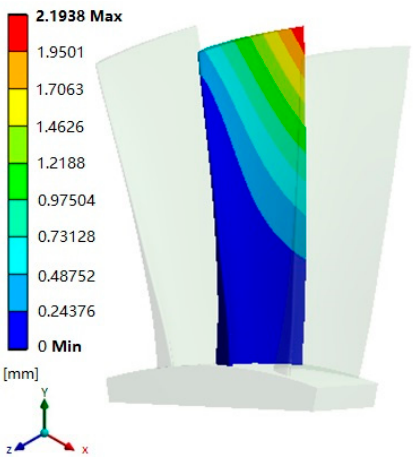
Figure 5. Total deformation distribution of the blade under centrifugal and aerodynamic loads.